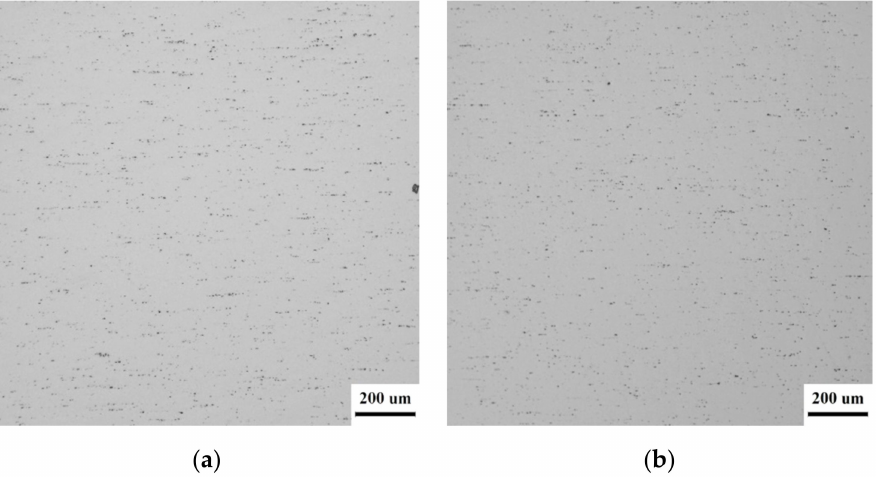
Figure 3. Metallographic photographs of the as-extruded and as-drawn states: ( a ) As-extruded state ( b ) As-drawn